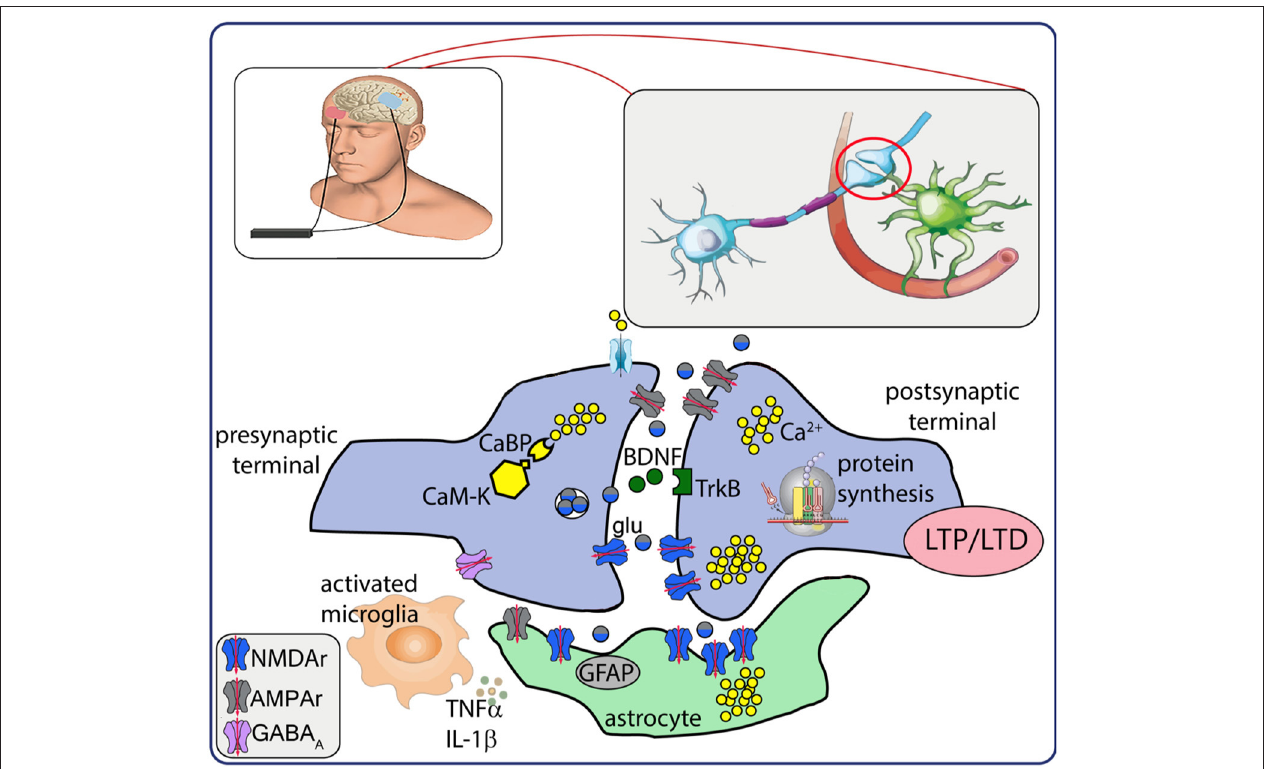
FIGURE 1 | Schematic representation of neurobiological after-effects of transcranial electrical stimulation (tES). tES induces intracellular Ca 2 + increase and activation of Ca 2 + -dependent enzymes (CaM-K). Presynaptic mechanisms result in glutamate release that activates AMPA/NMDA receptors, modulates BDNF release and interaction with TrkB receptor, responsible for a cascade of intracellular events that lead to de novo protein synthesis. Electrical stimulation also modulates activation of astrocytes and neuroinflammatory response. Altogether, these mechanisms may underlie the establishment of LTP/LTD. CaBP , Ca 2 + binding proteins; CaM-K , Ca 2 + kinases; glu , glutamate; BDNF , brain-derived neurotrophic factor; TrkB , tyrosine kinase receptor B; LTP/LTD , long term potentiation/depression; GFAP , glial fibrillary acidic protein; TNF α , tumor necrosis factor α ; IL-1 β , interleukin 1 β ; NMDAr , N-methyl-D- aspartate receptor; AMPAr , alpha-amino-3-hydroxy-5-methyl-4-isoxazolep ropionic acid receptor; GABA A , gamma amino butirric acid A